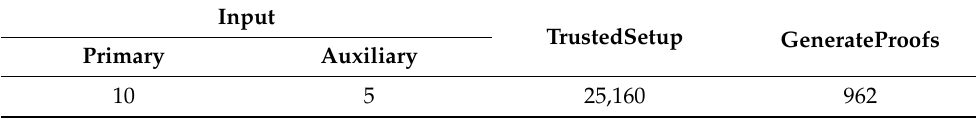
Table 5. The input file, trusted settings file, and proof file storage consumption (unit: